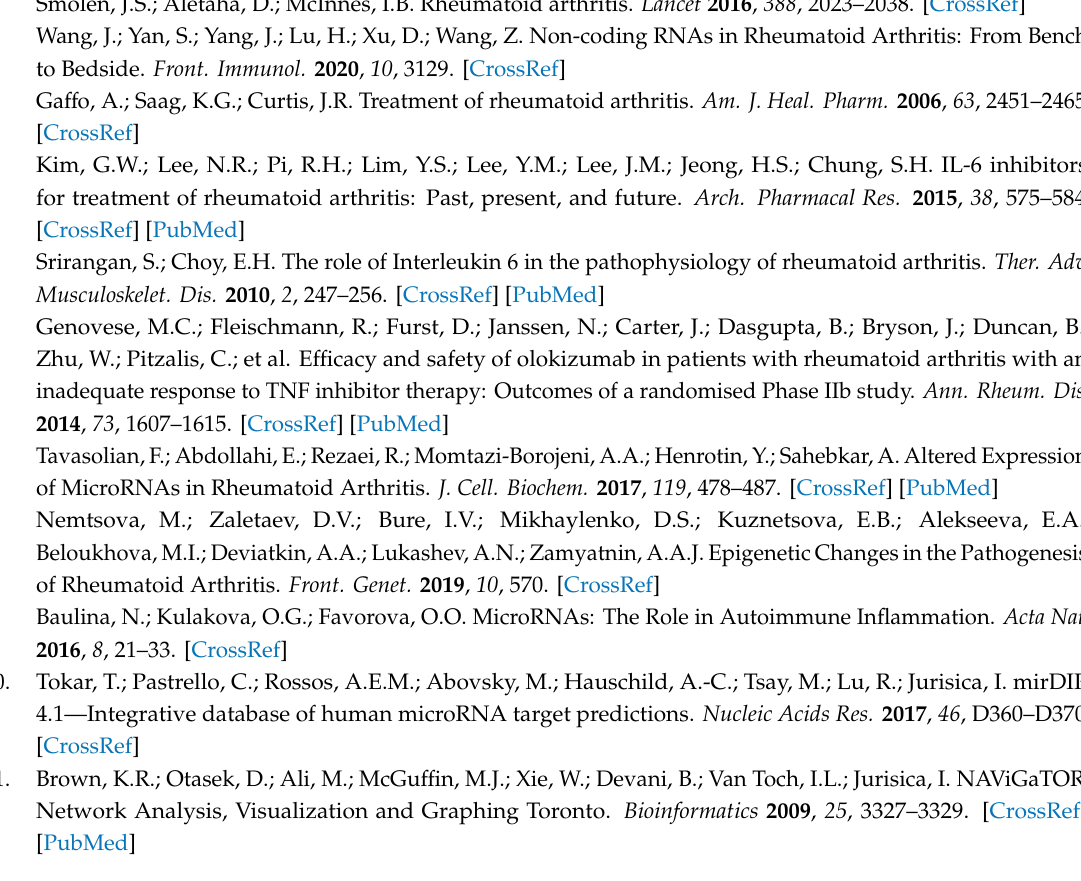
Supplementary Table S1: Statistically significant results of an association analysis between the baseline miRNA expression and the olokizumab therapy e ff ectiveness; Supplementary Table S2: An association analysis between the baseline miRNA expression and olokizumab therapy e ff ectiveness. Univariate and multivariate logistic